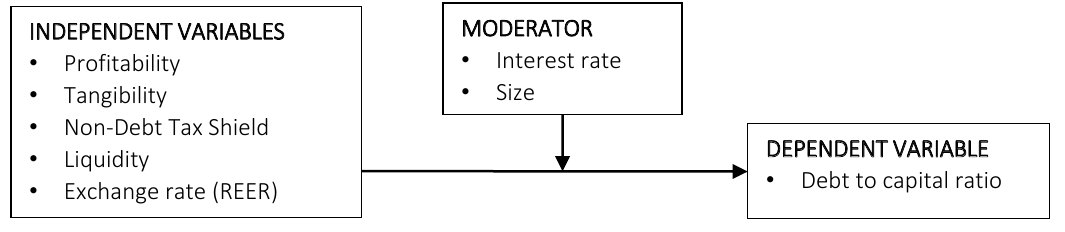
Figure 1. Conceptual